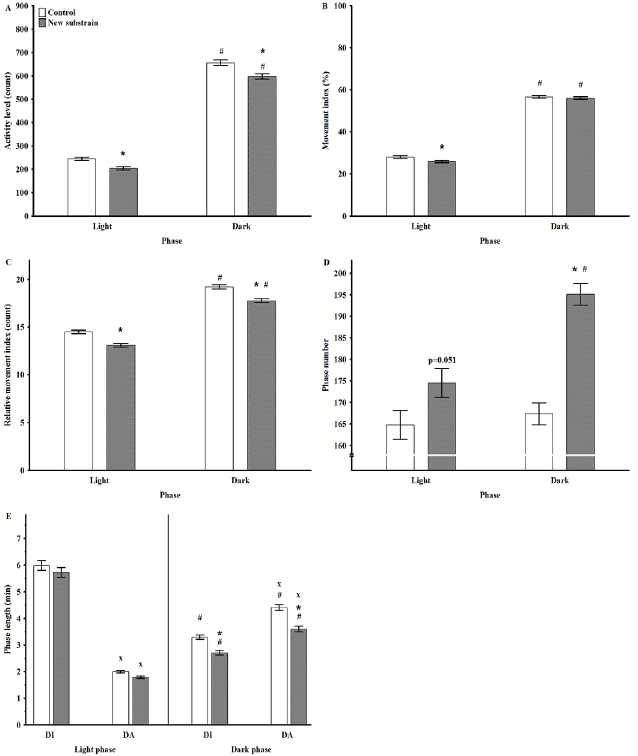
Fig 2. Motor activity parameters in undisturbed circumstances during light and dark phases. Mean AL (activity level; A), MI (movement index; B), RMI (relative movement index; C), PN (phase number; D), PL (phase length; E) with duration of uninterrupted immobility (DI) or active (DA) period. * p < 0.05 between groups; # < 0.05 between the day cycles; x p < 0.05 between the DI and DA. Data are presented as means ±